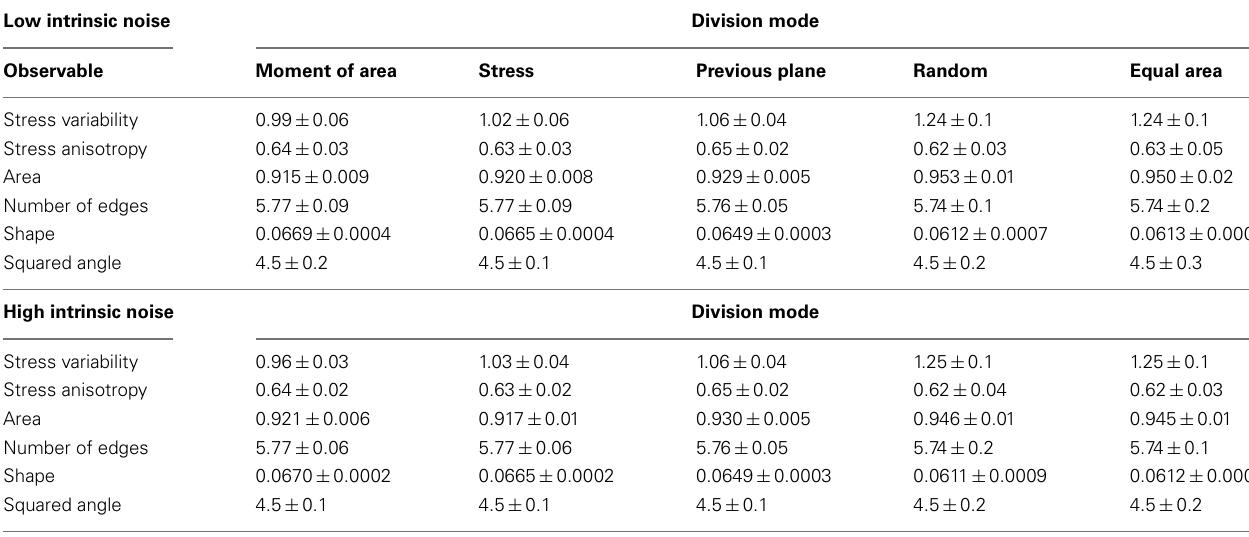
Table 1 | Mean value of observables characterizing tissue geometry, topology, and stress distribution for the different cell division modes at high and low intrinsic noise